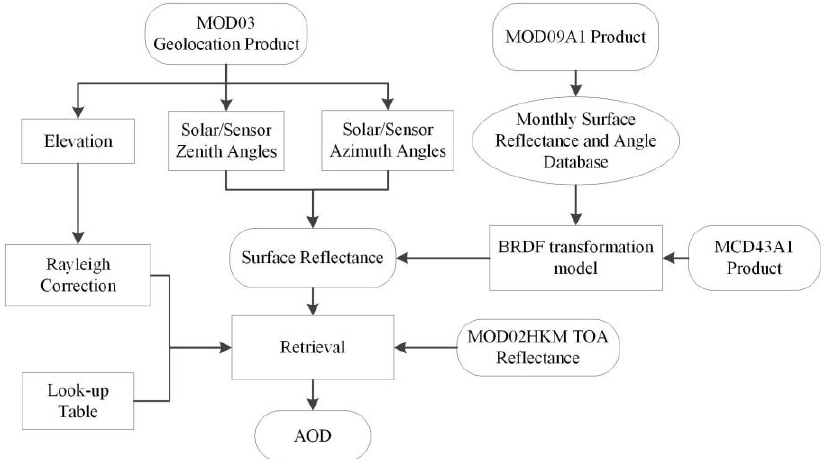
Figure 2. Flowchart of the aerosol retrieval algorithm in the study.